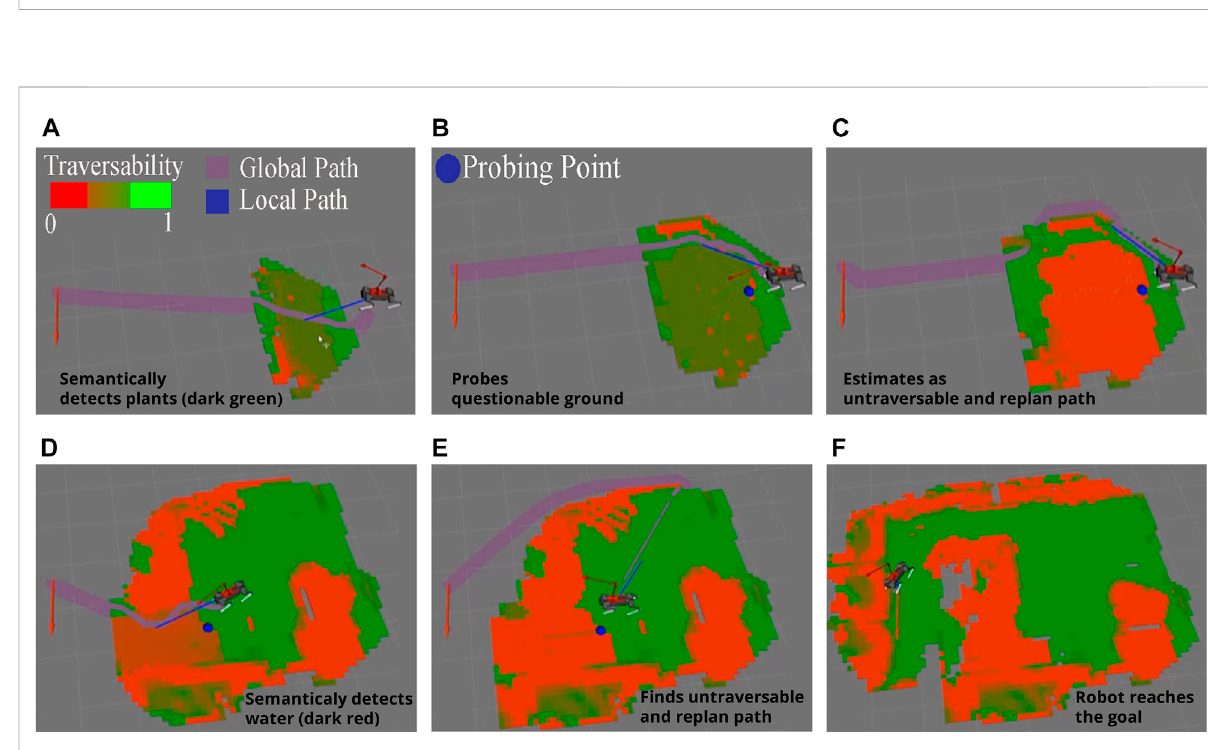
FIGURE 6 Global traversability maps in different stages in simulation scenario. (A) Robot detects semantically known plant, (B) probing arm starts probing the plant area, (C) detects collapsible soil under plant cover, (D) robot semantically detects the water and probing arm starts probing, (E) robot estimates water as collapsible ground and assigns untraversable score, (F) robot reaches the goal pose by avoiding untraversable